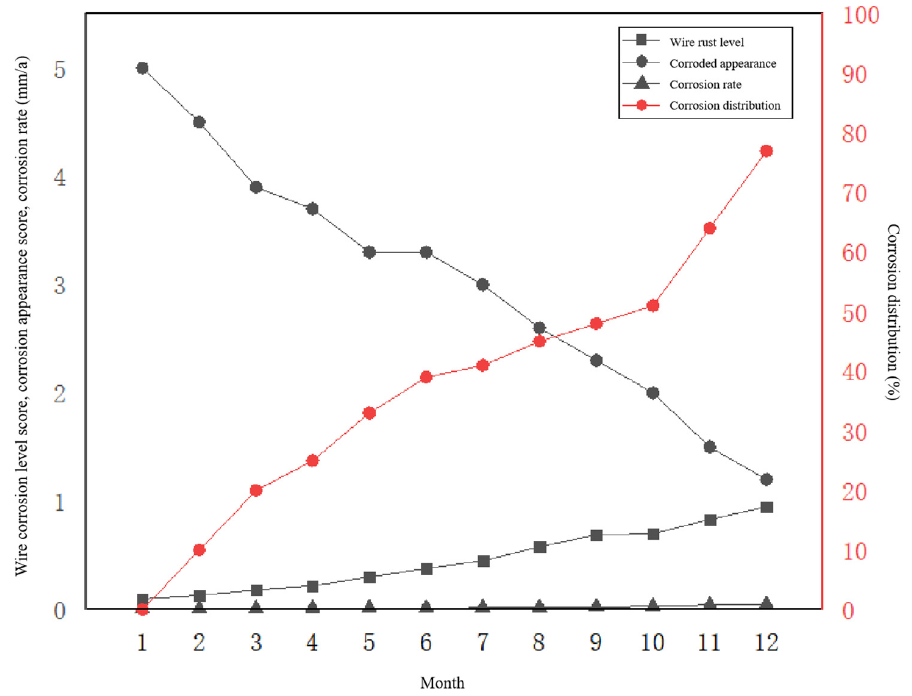
Figure 10. Annual variation curves of corrosion degree, corrosion rate, corrosion appearance, and corrosion distribution of the wire.